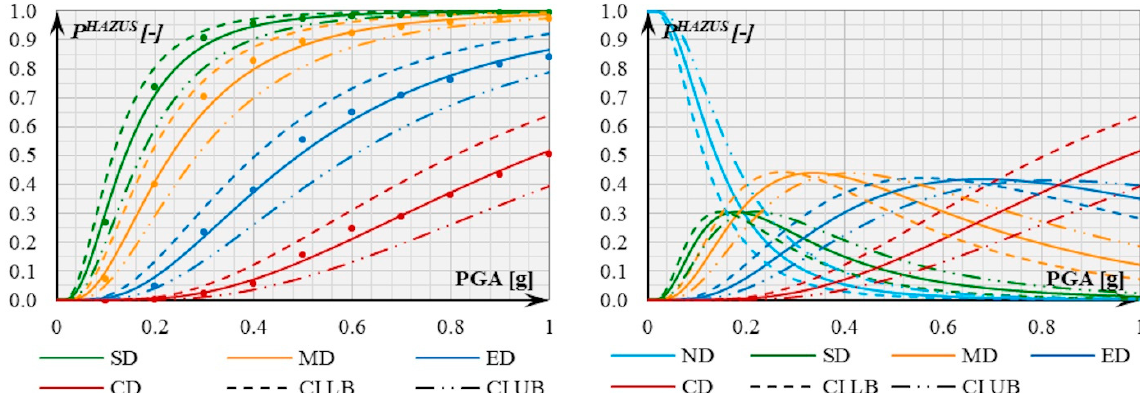
Figure 18. Fragility curves and probability density functions for the occurrence of different states of damage, according to HAZUS [32].